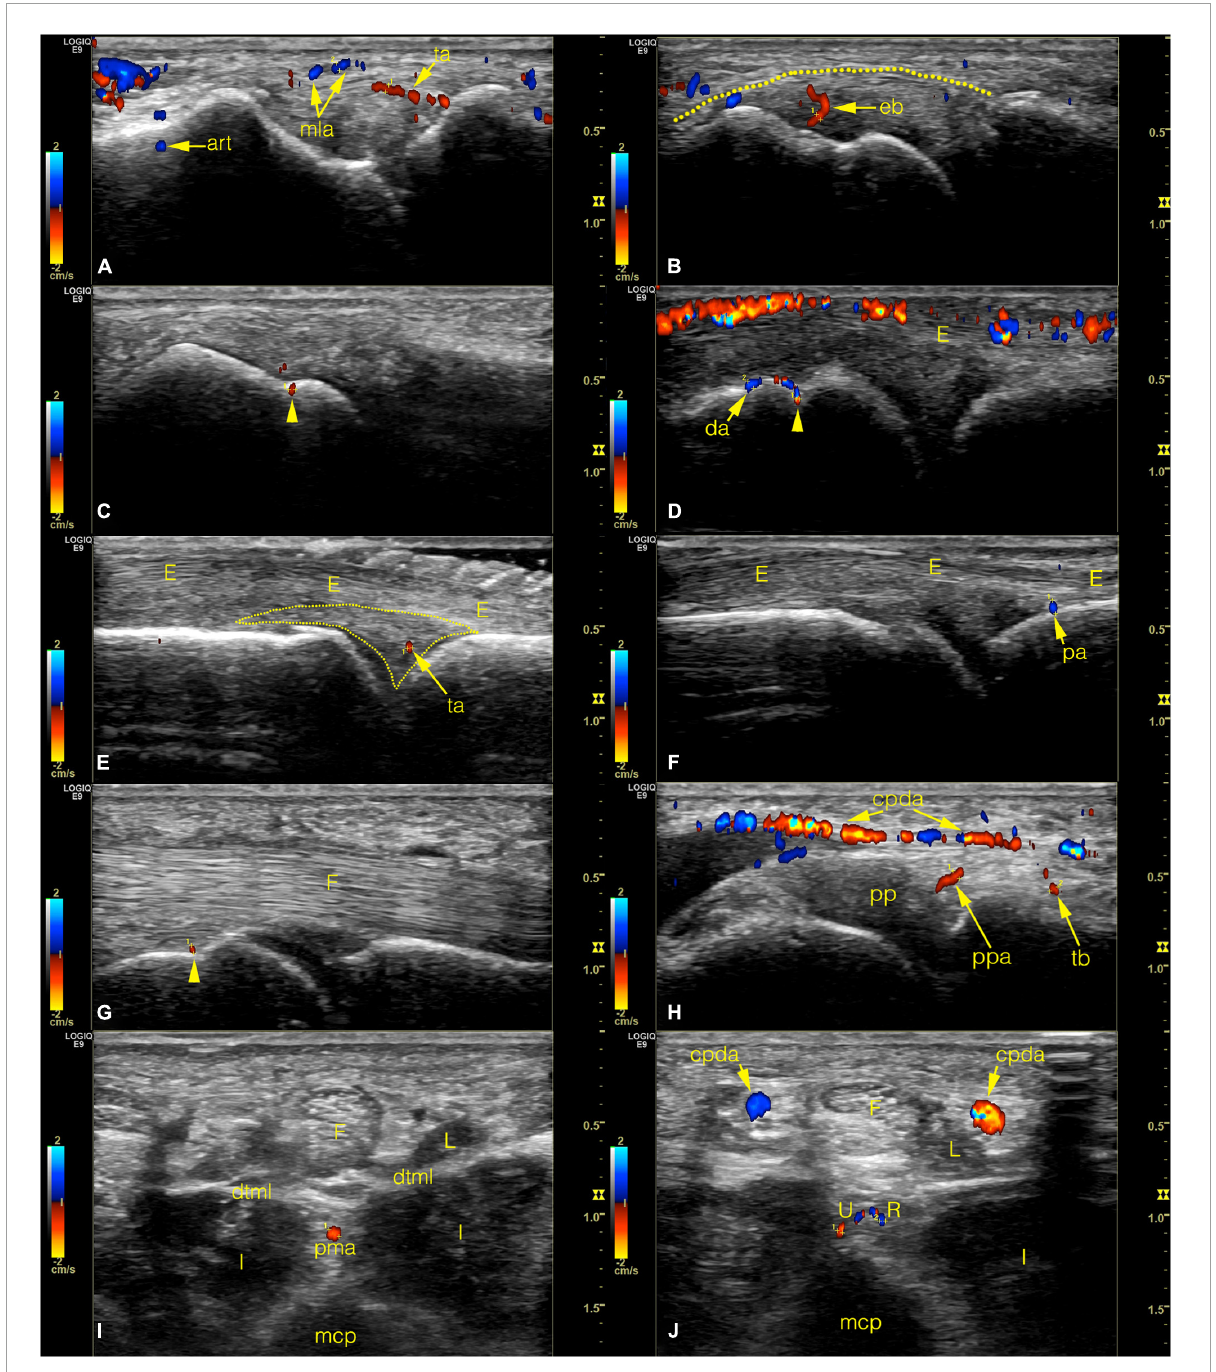
FIGURE7 Color Doppler ultrasonographic images of normal joint vessels on healthy volunteers. (Left side of the images refers to the metacarpal half.) (A–C) radial side of the 2nd joint on coronal plane. On panel (B) the dotted line indicates the outer border of the enthesis. (D–F) dorsal side of the joint on sagittal plane images. Note the superficial cutaneous vein along the top of panel (D) . On panel (E) the dotted line indicates the dorsal triangle. (G,H) palmar side on sagittal plane. (I,J) axial plane images with the homuncule shaped soft tissue complex in the center with palmar metacarpal artery and it’s bifurcation into R- and U-branches, respectively. arrowhead, entry point of a bone supplying vessel; art, Doppler mirror artifact; cpda, common palmar digital artery; da, dorsal arcade; dtml, deep transverse metacarpal ligament; eb, enthesial branch; E, extensor tendon; F, flexor tendon; I, interosseous muscle; L, lumbrical muscle; mcp, metacarpal; mla, main lateral artery; pa, phalangeal arcade; pma, palmar metacarpal artery; pp, palmar plate; ppa, palmar plate artery; ppda, proper palmar digital artery; R, R-branch; ta, triangular arcade; tb, tenosynovial trunk; U,